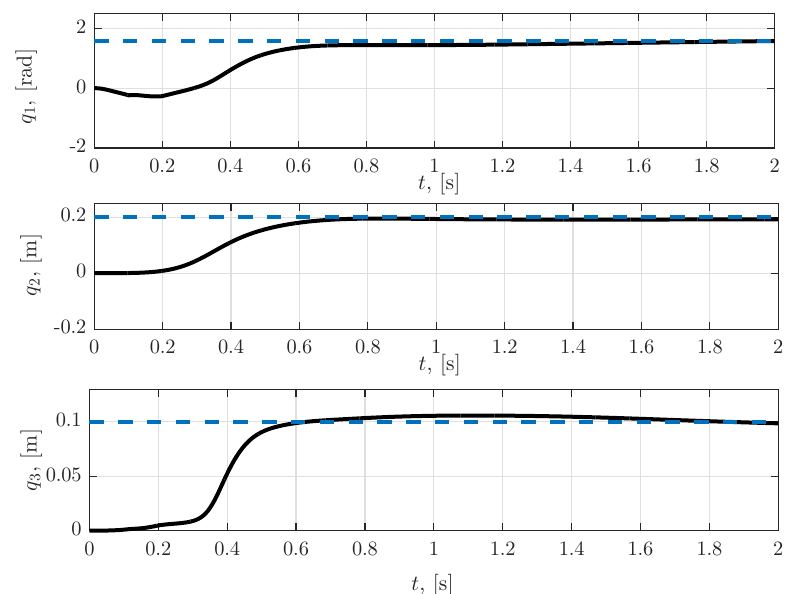
Figure 4. Time responses of the rotational coordinates of the first joint, and of the translational coordinates of the second and third joints.